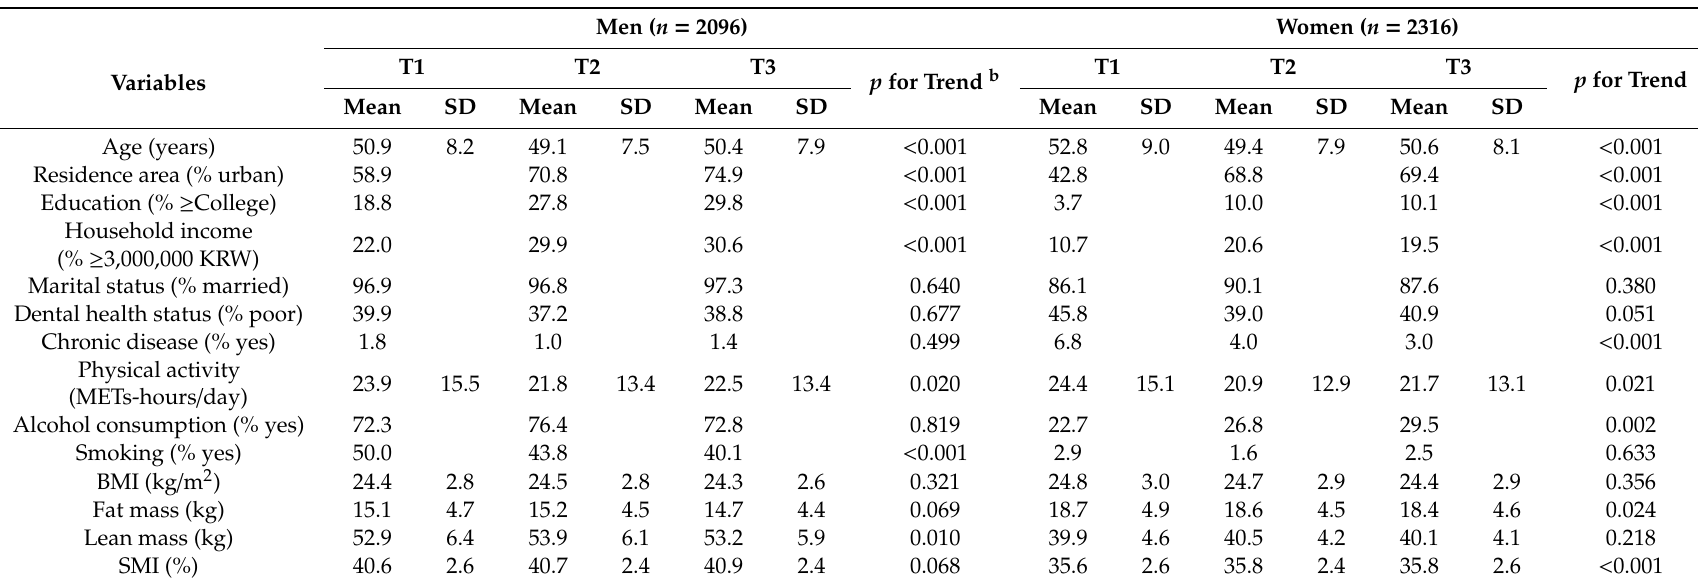
Table 1. General characteristics of study participants according to tertiles of dairy protein intake a at